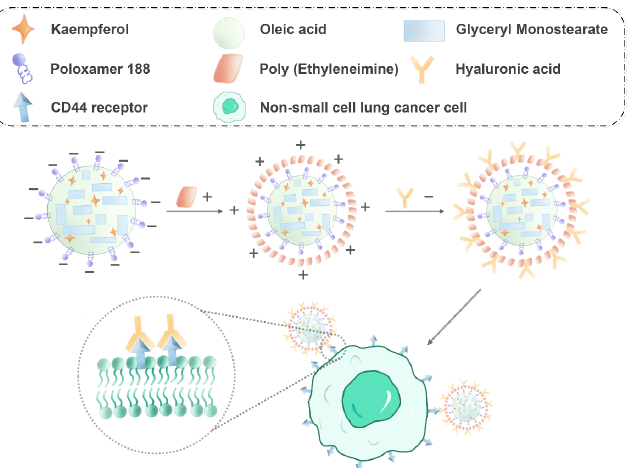
Figure 1. Schematic diagram of HA-KA-NLC for NSCLC cell treatment (the minus and plus signs represent negative and positive charges, respectively).